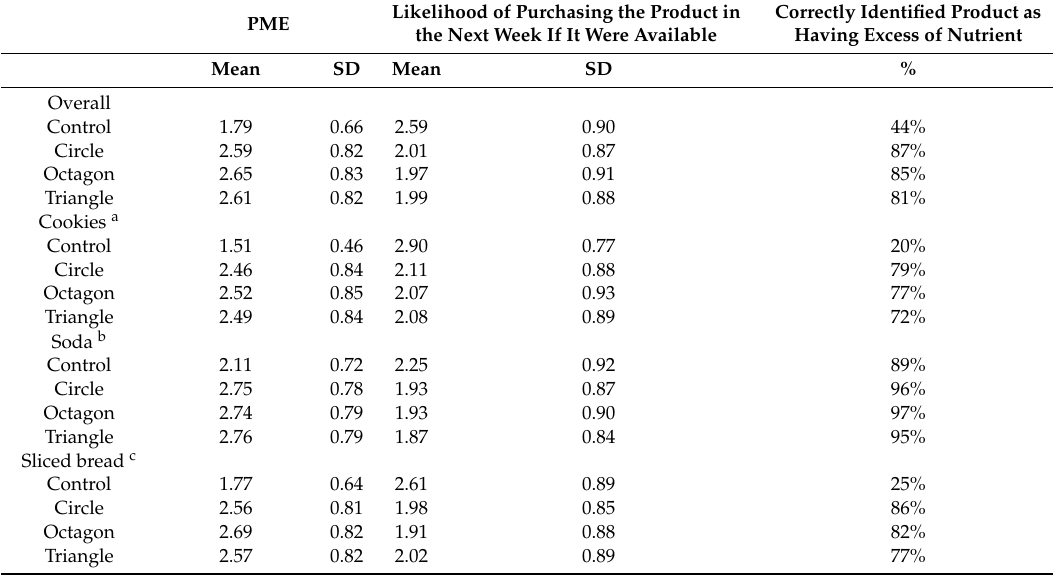
Table A2. Raw means and proportions by label type, for single product assessment task and label reactions.